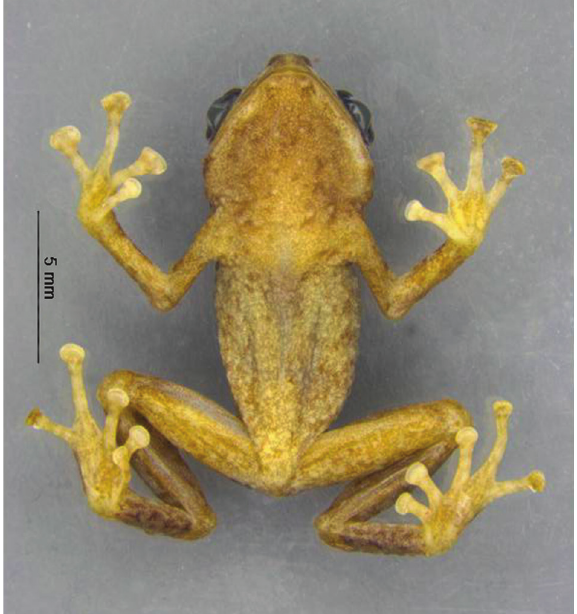
Figure 5a. Preserved holotype of Choerophryne multisyllaba sp. n. in dorsal Table 2. Body measurements and body ratios of the type series of Choerophryne multisyllaba sp. n. SAMA R70322 is the holotype, all types are adult males, all measurements in mm; for explanation of abbreviations see Table 1.